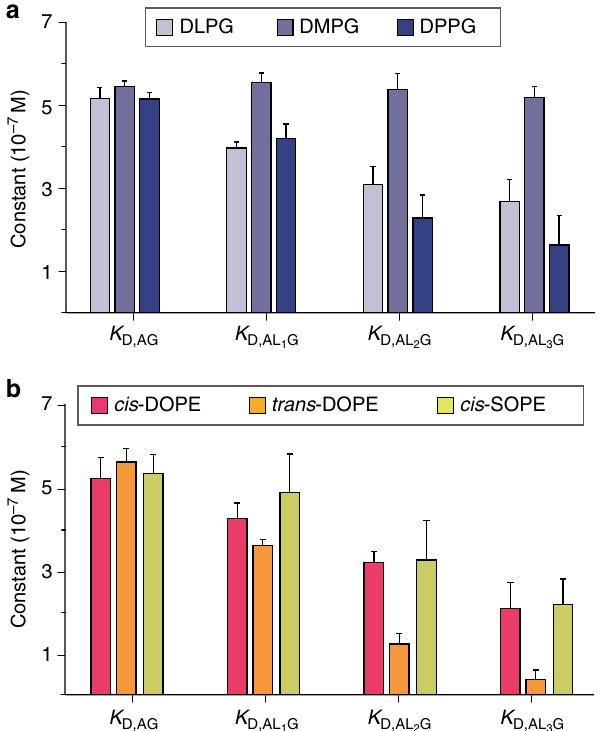
Fig. 4 Native mass spectrometry reveals the effect of lipid tail chemistry on allosteric modulation of AmtB – GlnK. a Plot of equilibrium dissociation constants ( K D ) for GlnK binding apo AmtB and AmtB bound to PG lipids with increasing acyl chain length: 12 (DL, 1,2-dilauroyl), 14 (DM, 1,2- dimyristoyl), and 16 (DP, 1,2-dipalmitoyl). b Plot of K D for GlnK binding apo AmtB and AmtB bound to PE lipids with different stereochemistry: dioleoyl